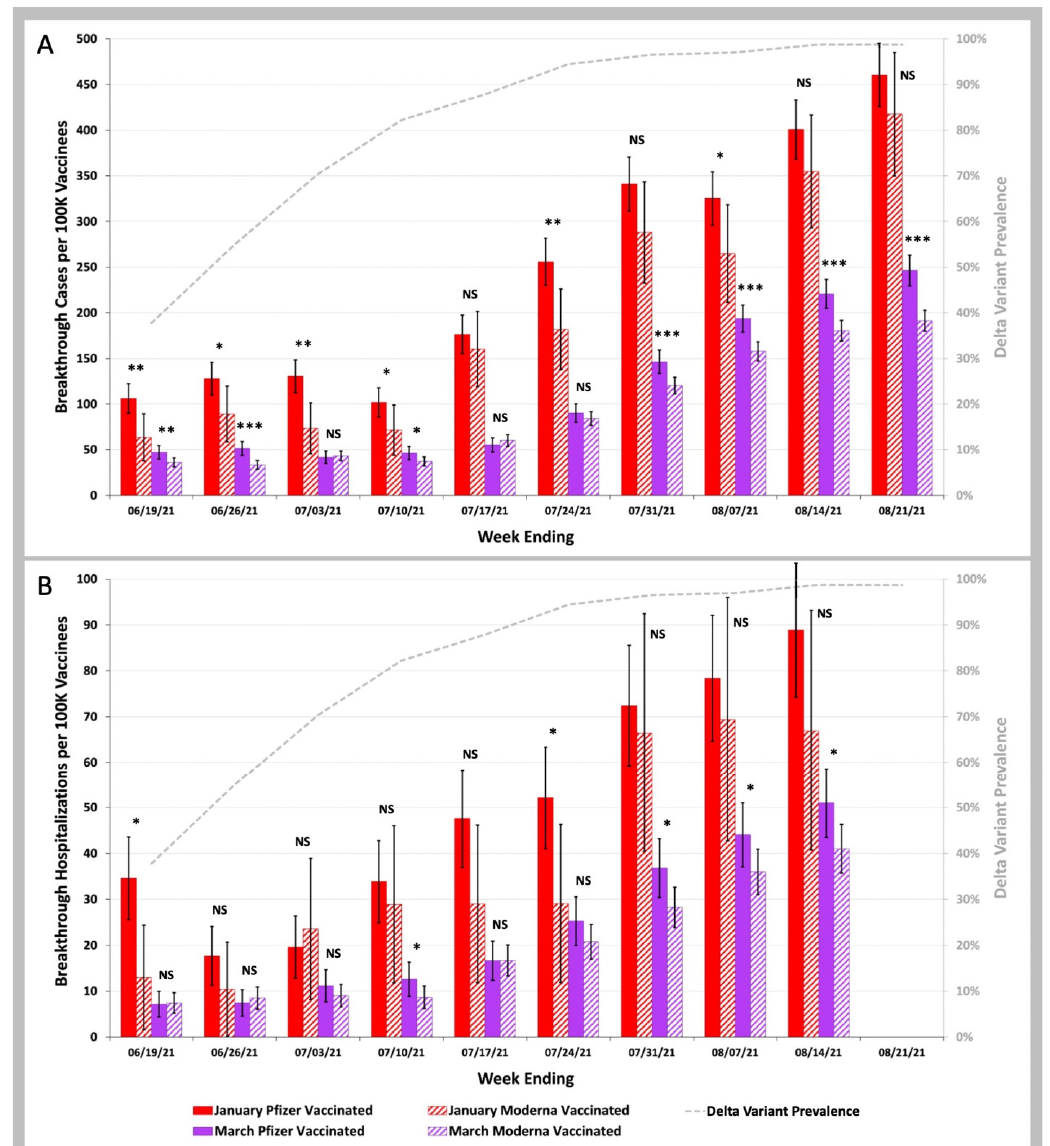
Figure 4. COVID-19 breakthrough infection and hospitalization rates in individuals vaccinated in the January Group vs. those vaccinated in the March Group with either the Pfizer-BioNTech BNT162b2 or the Moderna mRNA-1273 vaccine. ( A )—Weekly infection rates per 100 K individuals vaccinated in the January Group (red bars) vs. those vaccinated in the March Group (purple bars), with either the Pfizer-BioNTech BNT162b2 (solid bars) or the Moderna mRNA-1273 (striped bars) vaccines. ( B )—Weekly hospitalization rates per 100 K individuals vaccinated in the January Group (red bars) vs. those vaccinated in the March Group (purple bars), with either the Pfizer-BioNTech BNT162b2 (solid bars) or the Moderna mRNA-1273 (striped bars) vaccine. Weekly SARS-CoV-2 Delta variant prevalence reported by the CDC (gray dashed line). Error bars indicate 95% CI. Symbols shown above the red bars (January 2021 vaccinees) or purple bars (March 2021 vaccinees) indicate p values for weekly rates for those vaccinated with the Pfizer-BioNTech BNT162b2 vaccine being greater than weekly rates for those vaccinated with the Moderna mRNA-1273 vaccine. NS p ≥ 0.05; * p < 0.05; ** p < 0.01; *** p < 0.001 by two-proportion